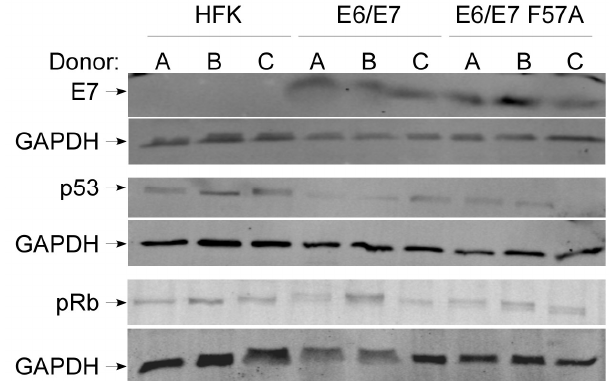
Figure 1. Characterization of E6 / E7 and E6 / E7 F57A cell lines. Western blot analysis of protein levels of E7 (top panel), p53 (middle panel), pRb (bottom panel), and glyceraldehyde-3-phosphate dehydrogenase (GAPDH) in human foreskin keratinocytes (HFKs), pLXSN E6 / E7, and pLXSN E6 / E7 F57A cells grown in monolayer culture. Three HFK donors ( A – C ) were used.